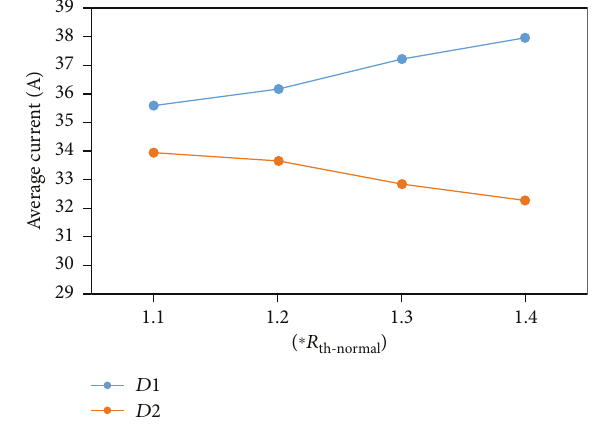
Figure 10: The average